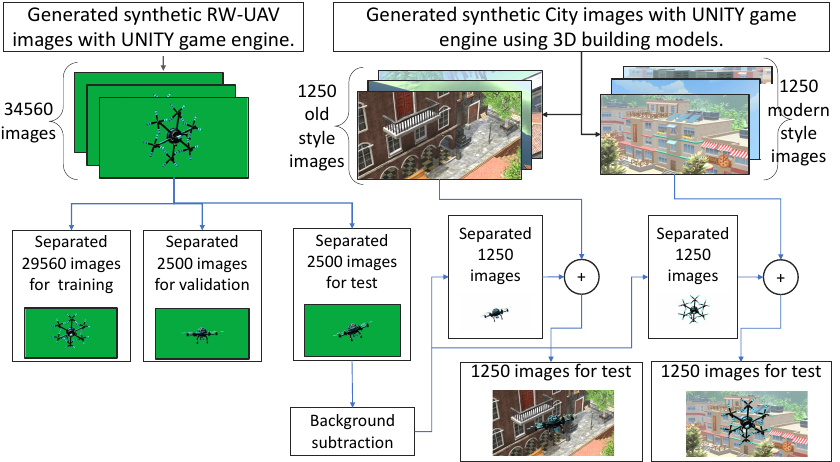
Figure 4. The schematic representation related to the creation of a dataset of the RW-UAV